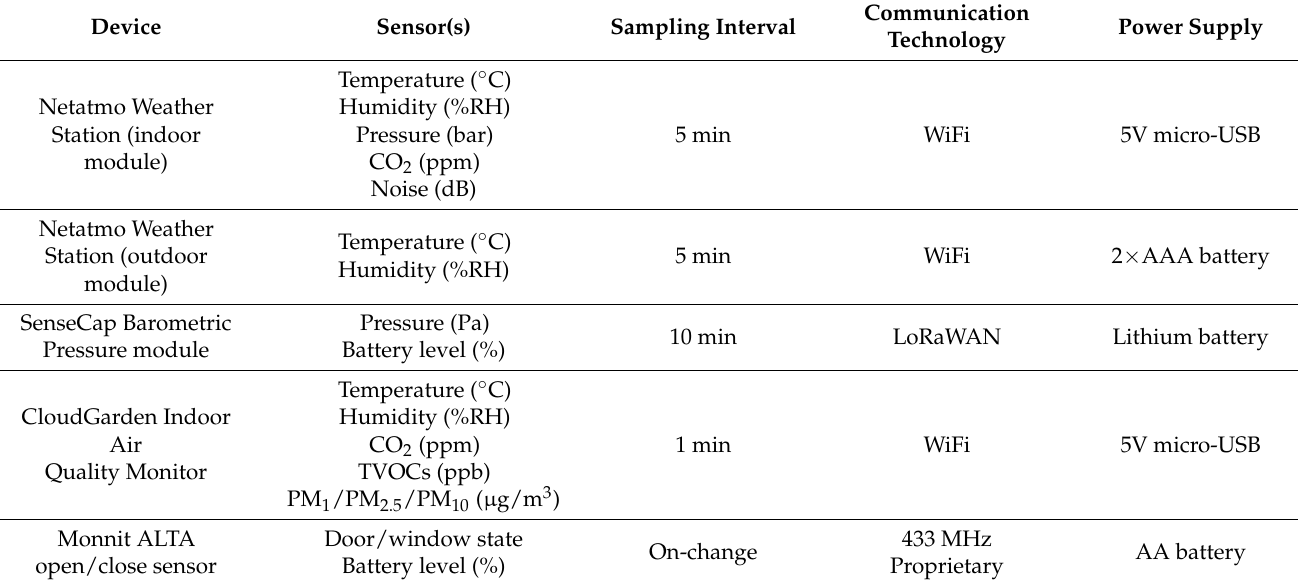
Table 3. Sensing devices used in